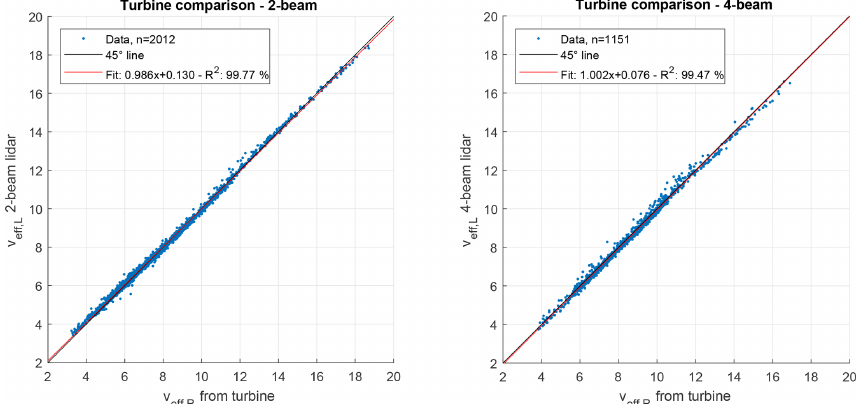
Figure 7. Comparison of 10min REWS estimates between the lidars and the turbine. Data from the wake sector and non-operational periods of the turbine were removed. All units are ms − 1